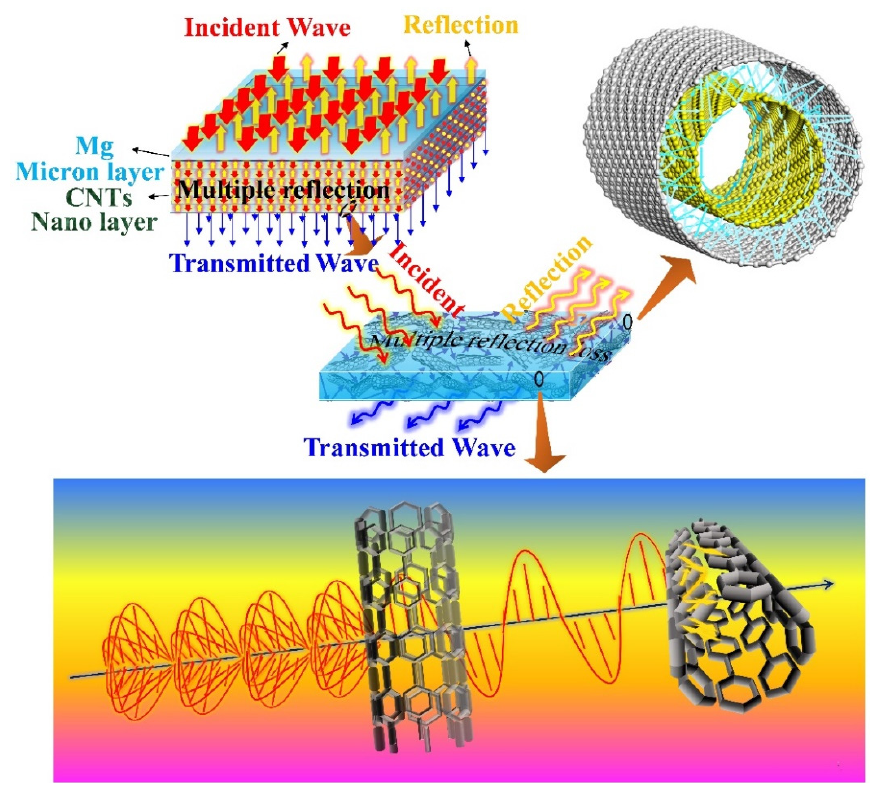
Figure 14. Schematic diagram of the EMI shielding mechanism in the laminated CNTs/Mg composites.